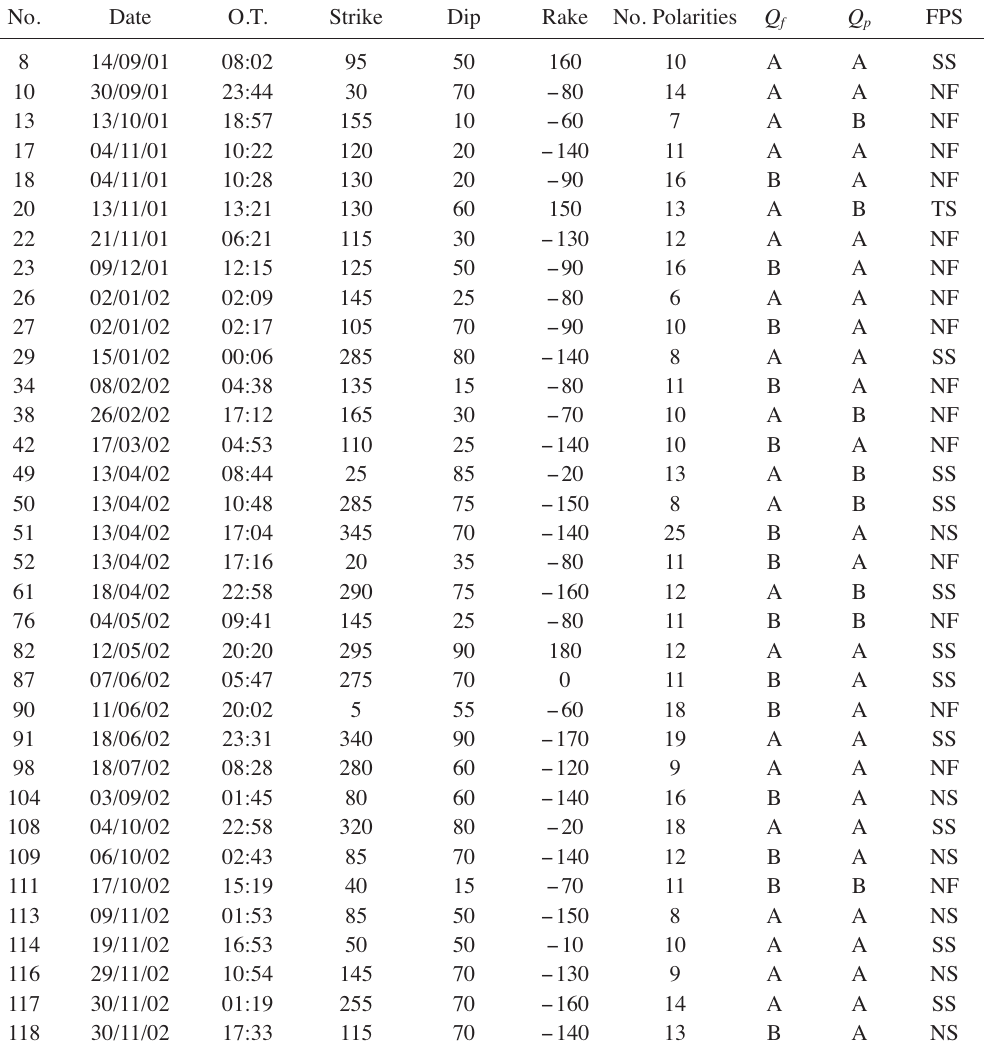
Table IV . Parameters of the computed fault-plane solutions. Event numbers correspond to those in table III. It is reported the strike, dip and rake of one of the two nodal planes, number of polarities, quality factor ( Q f , Q p , see also table V) and stress regime categories (FPS): normal faulting (NF), predominately normal with strike- slip component (NS), strike-slip faulting (SS) and predominately thrust with strike-slip component (TS).